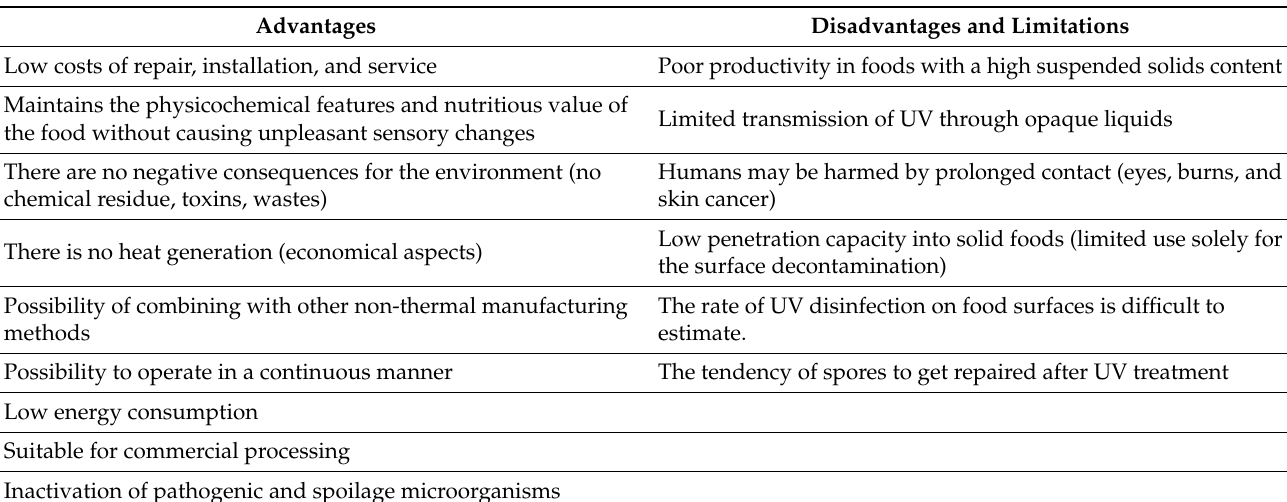
Table 4. UV radiation handling of dairy products: Advantages, disadvantages, and limitations